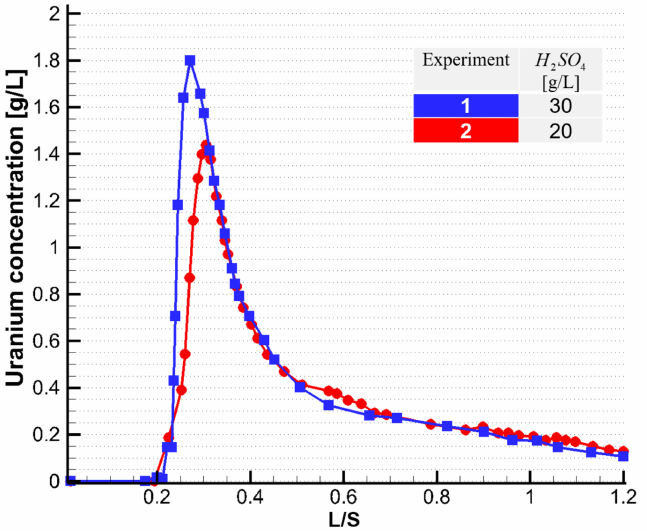
Figure 3. Dissolved mineral concentrations against L/S for the two experiments after [5].